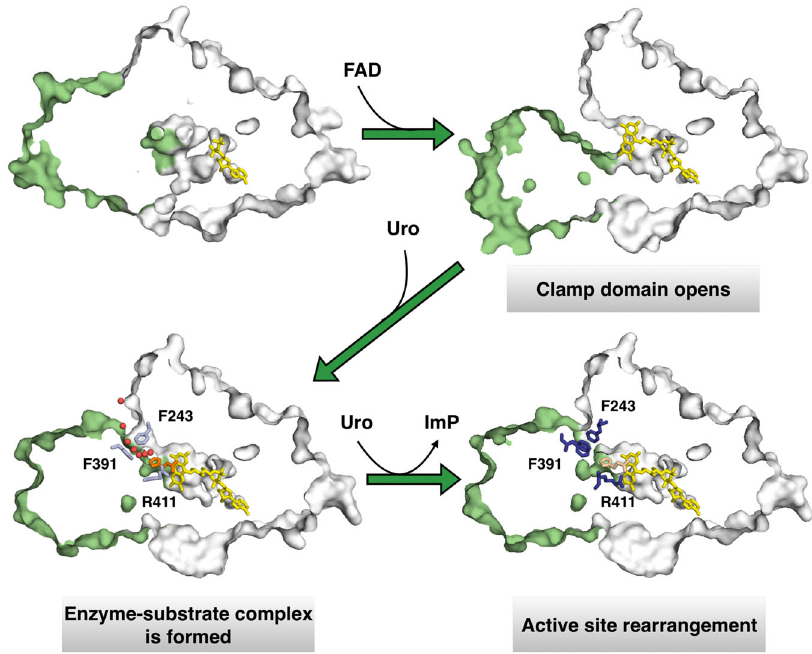
Fig. 5 The structural mechanism of action of UrdA. Schematic illustration of the conformational changes upon FAD and substrate/product binding in the active site. Clamp domain shown in green and FAD domain in white, ADP/FAD (yellow), urocanate (orange), imidazole propionate (wheat), and water molecules (red spheres)